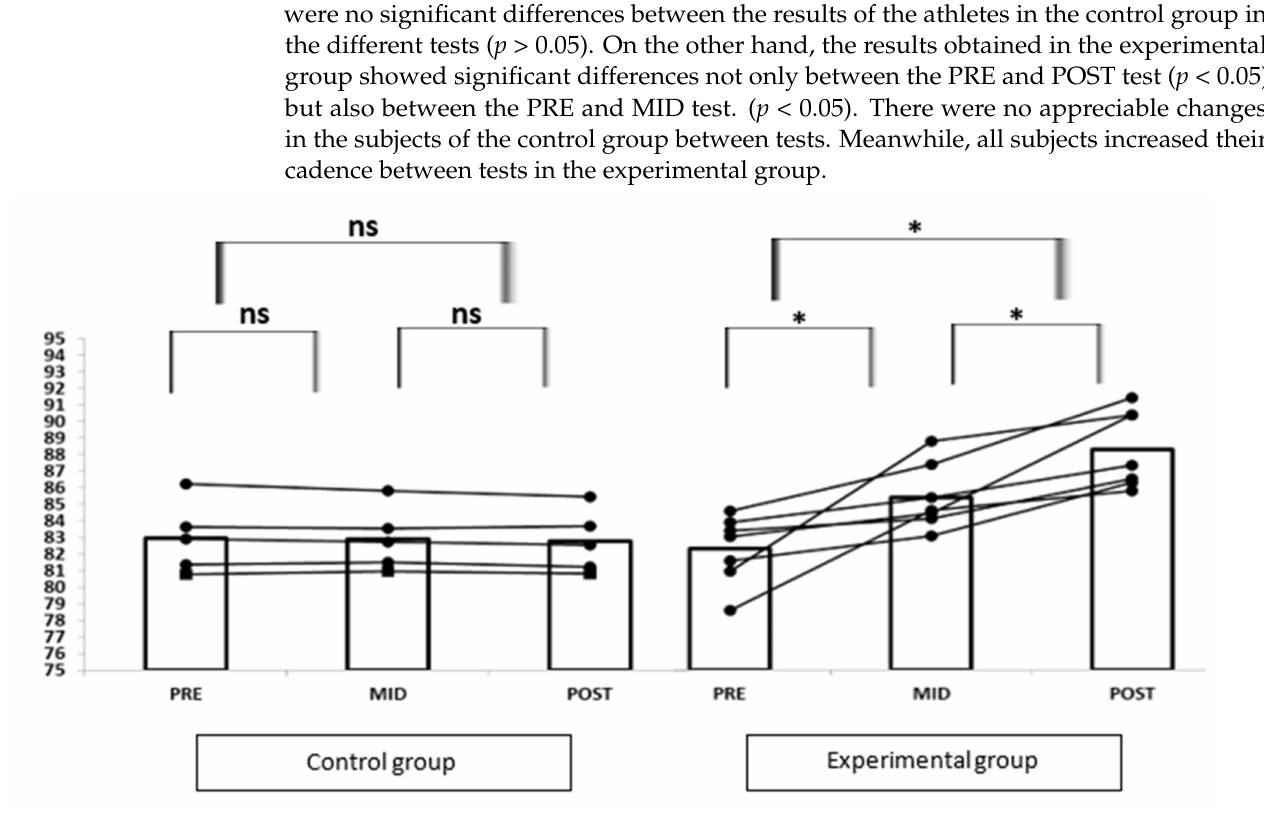
Figure 2. Graph of cadence evolution in the control group and the experimental group. The nonpara- metric Wilcoxon test was used for the detection of significant difference between the tests (* p < 0.05). No significant difference was found between the tests (ns: p > 0.05). Data are presented individually for each participant and as overall